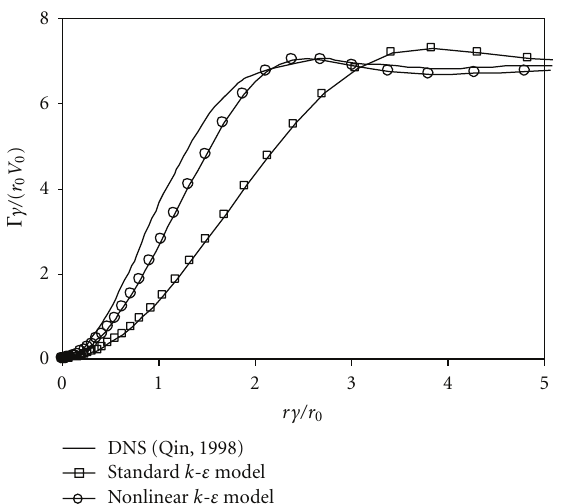
Figure 5: k - ε model prediction of circulation profile compared with Qin’s DNS results ( t = 3.72 T ).